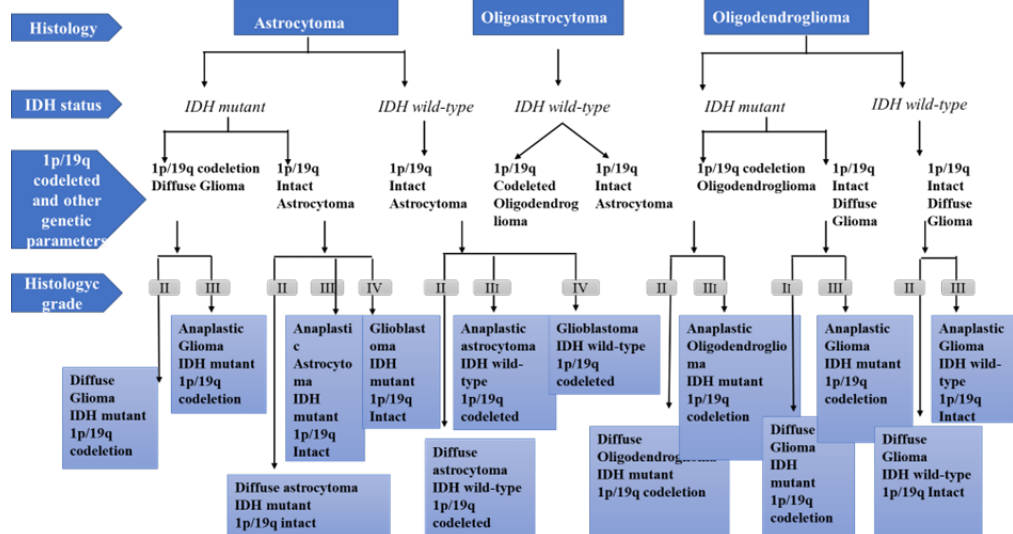
Figure 1. Diagnostic algorithm for diffuse gliomas, based on the WHO classification.